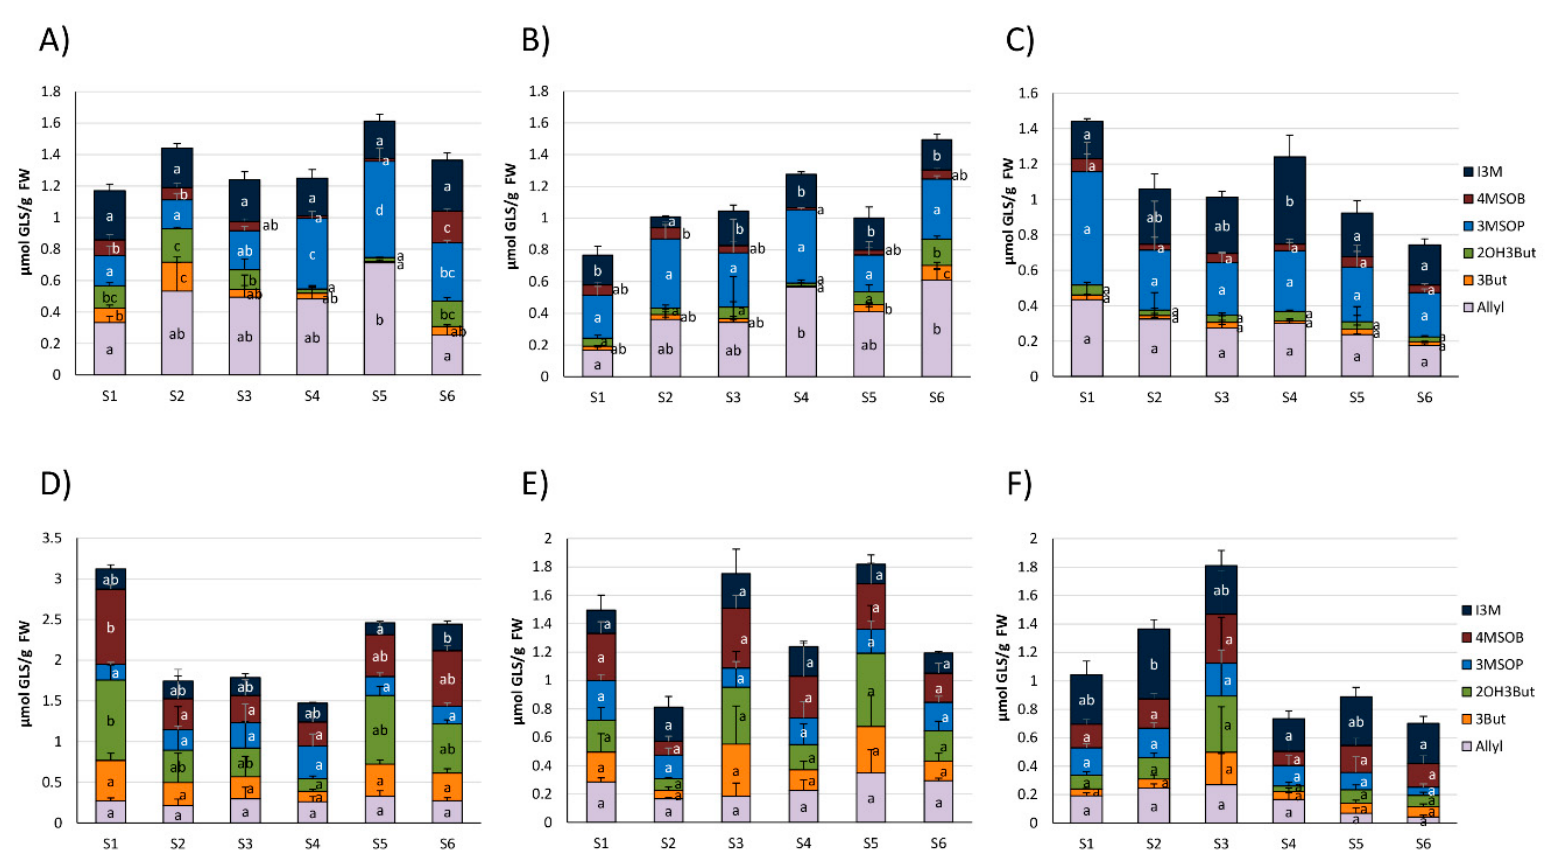
Figure 1. Glucosinolate (GLS) profile in white ( A – C ) and red cabbages ( D – F ) from conventional ( A , B , D , E ) and organic supermarkets ( C , F ) on di ff erent sampling dates (S1–S6). Exact sampling dates can be found in Table 1. A) and D) Represent conventional supermarket 1 (CON 1 ), B) and E) stand for conventional supermarket 2 (CON 2 ), and C) and F) show results from organic supermarket 1 (ORG 1 ). Each color in the bar of the given bar chart represents the mean plus standard deviation (SD) of the GLSs from three cabbage heads from the same supermarket ( n = 3). Lower case letters indicate significant di ff erences in means between the levels of a GLS on di ff erent sampling dates, as tested by ANOVA and Tukey HSD test at the p ≤ 0.05 level. Abbreviations: FW: Fresh weight; abbreviations of compounds as listed in Table 3.